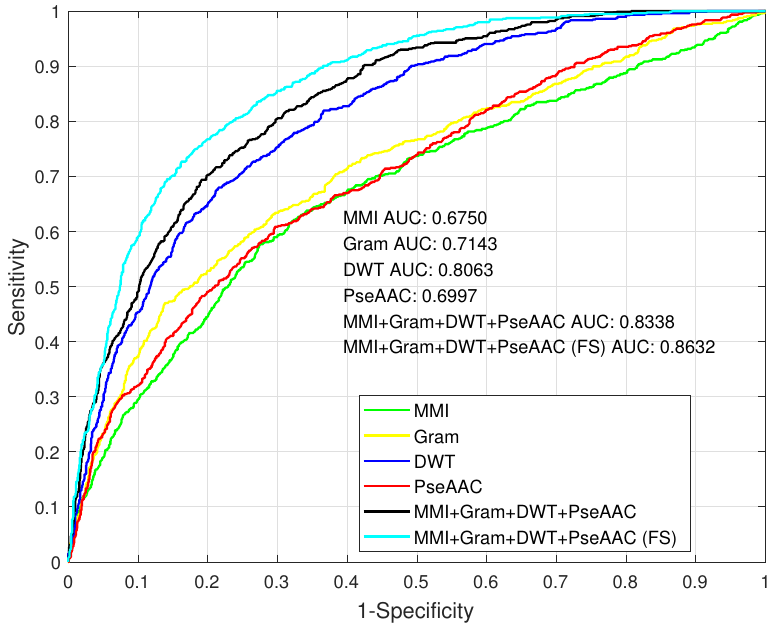
Figure 3. The receiver operating characteristic (ROC) of classifiers by using different